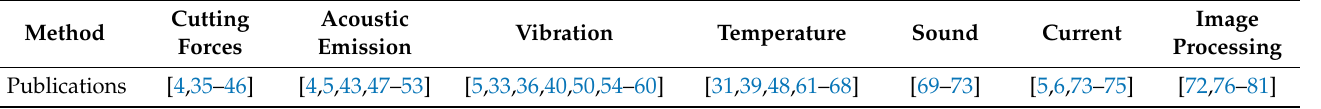
Figure 3. An example for an indirect tool condition monitoring system [35]. Table 1. Publications that used different methods in indirect tool condition monitoring system.